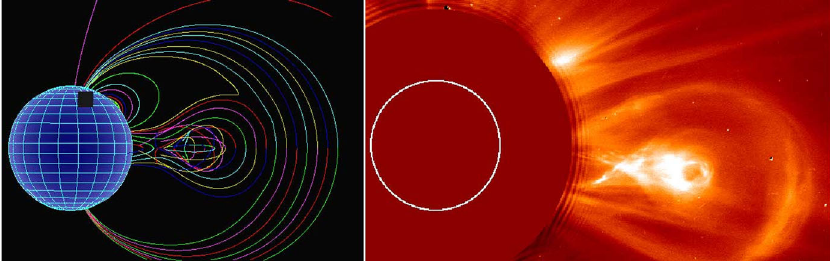
Fig. 16 Left a schematic drawing of the one-loop flare model. Right observation of an apparent X-point behind a coronal mass ejection observed by LASCO/SOHO in white light (copyright by